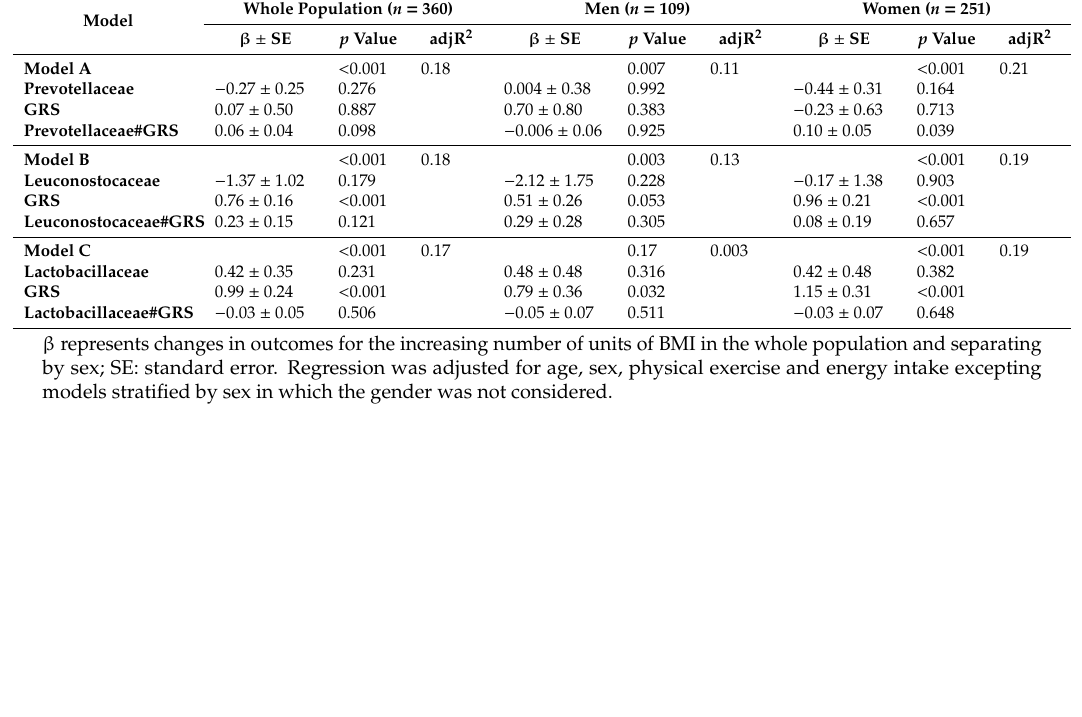
Figure 5. Ranking of mean decrease in accuracy (MDA) values in random forest analysis, a statistical classification that indicates the importance of each variable. Random forest calculates feature importance by removing each feature from the model and measuring the decrease in accuracy (for presence) or the increase in the mean-square error (for abundance). According to these importance scores, features were ranked in increasing order across models. The plot shows each variable on the y-axis, and their importance on the x-axis. Thus, the most important variables are at the top and an estimate of their importance is given by the position of the dot on the x-axis. ( A ) The Figure Shows the hierarchical rank of 30 families listed as responsible for the differences between groups of BMI. ( B ) The graph shows the hierarchical rank of importance of 30 bacterial families implicated in the differences between groups of GRS. Table 3. Linear regression models constructed with BMI as dependent variable, relative abundance of Prevotellaceae family, and genetic risk score (GRS) as independent variables.